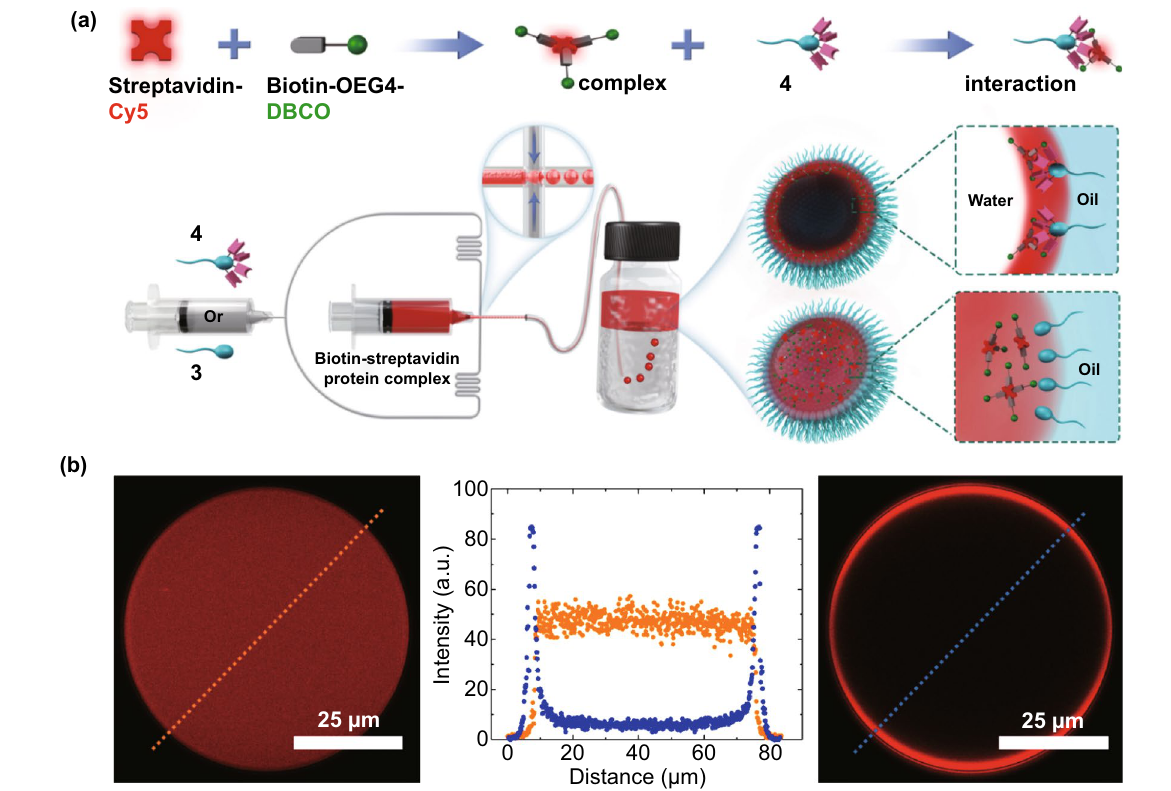
Fig. 3 Microfluidic approach to surfactant-stabilized drops for fishing biomolecules a Mixing of Cy5 dye‑labeled streptavidin (4‑lock in red) with biotin (key in gray) connected via OEG4 (gray stick) to the strained cyclooctyne (green sphere) created a complex of biotin–streptavidin. This complex interacted with the surfactant 4, which contained azide groups (pink symbols) (the top panel). The bottom panel shows microflu‑ idics generation of the complex‑encapsulated drops using either surfactant 3 or 4 where the drops are pinched‑off at the channel cross section (middle inset). The interior of the drop at the top inset shows the migration of complexes to the drop interface (successful fishing) with sur‑ factant 4. By contrast, the interior of the drop at the bottom inset shows a homogeneous distribution of the complexes across the drop (no fish‑ ing) with surfactant 3. b 2D confocal fluorescent images of the complex‑encapsulated drops and their fluorescence intensity profiles. The drops were stabilized by surfactant 3 (left) and surfactant 4 (right). In the intensity profiles plotted as a function of distance (middle), the orange line represents the spatial intensity of the drop of the left image and the blue one denotes the spatial intensity of the drop of the right